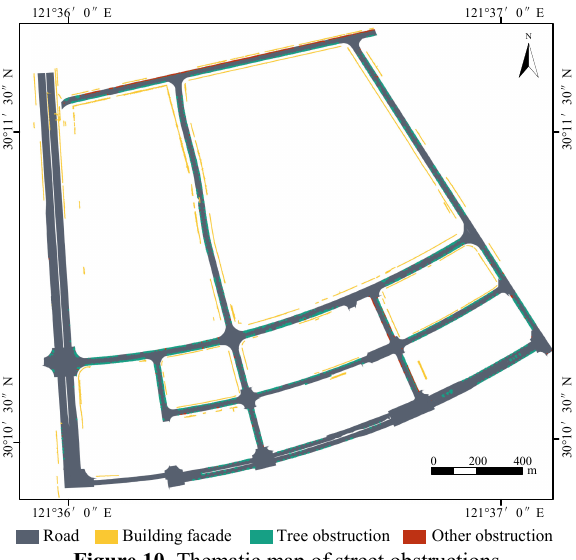
Figure 10. Thematic map of street